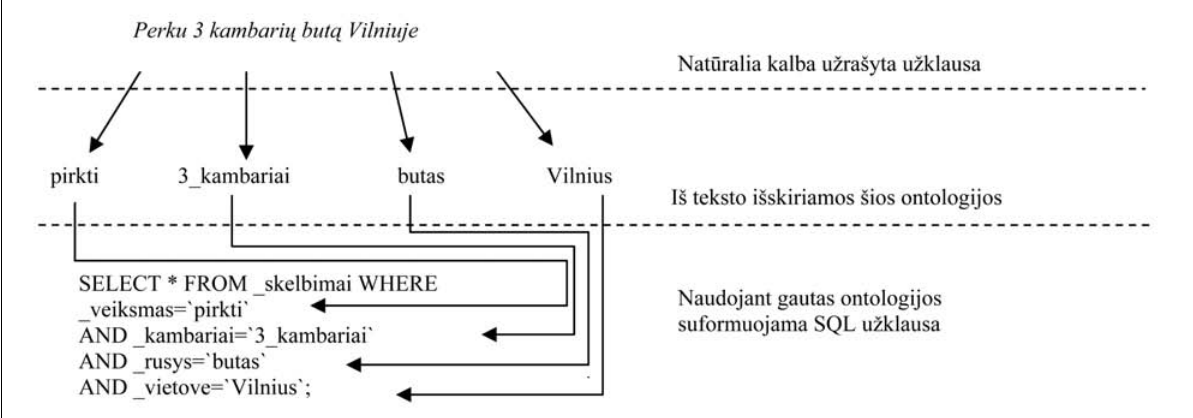
tikai buvo prataikyti MySQL 5.0 DBVS trigeriai. Statisti- ka įrašoma į atskirą lentelę.